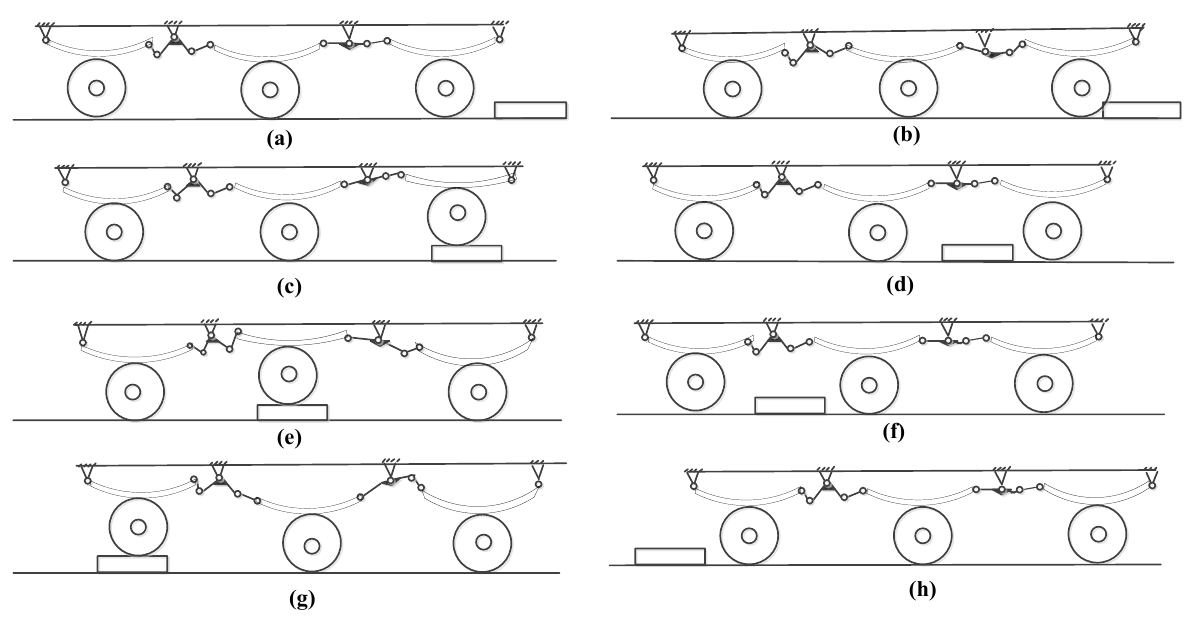
Figure 6. Obstacle surmounting process of boss: ( a – c ) the process of front wheel crossing the boss; ( d , e ) the process of middle wheel crossing the boss; ( f – h ) the process of rear wheel crossing the boss.